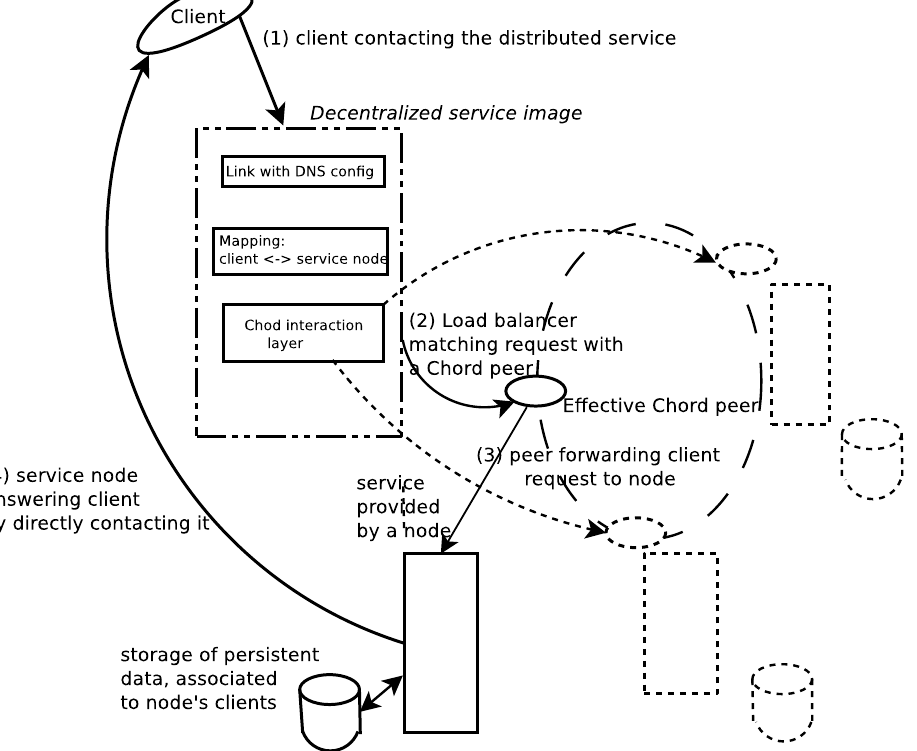
Figure 3. Generic handling of a client by the decentralized distributed